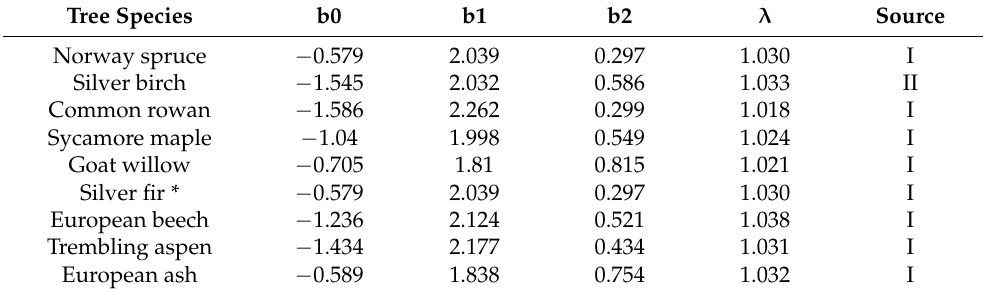
Table 1. Coefficients ( b 0 , b 1 , b 2 ) and correction factors ( λ for allometric equations (Formula (1)) expressing aboveground tree biomass based on stem base diameter and tree height as indepen- dent